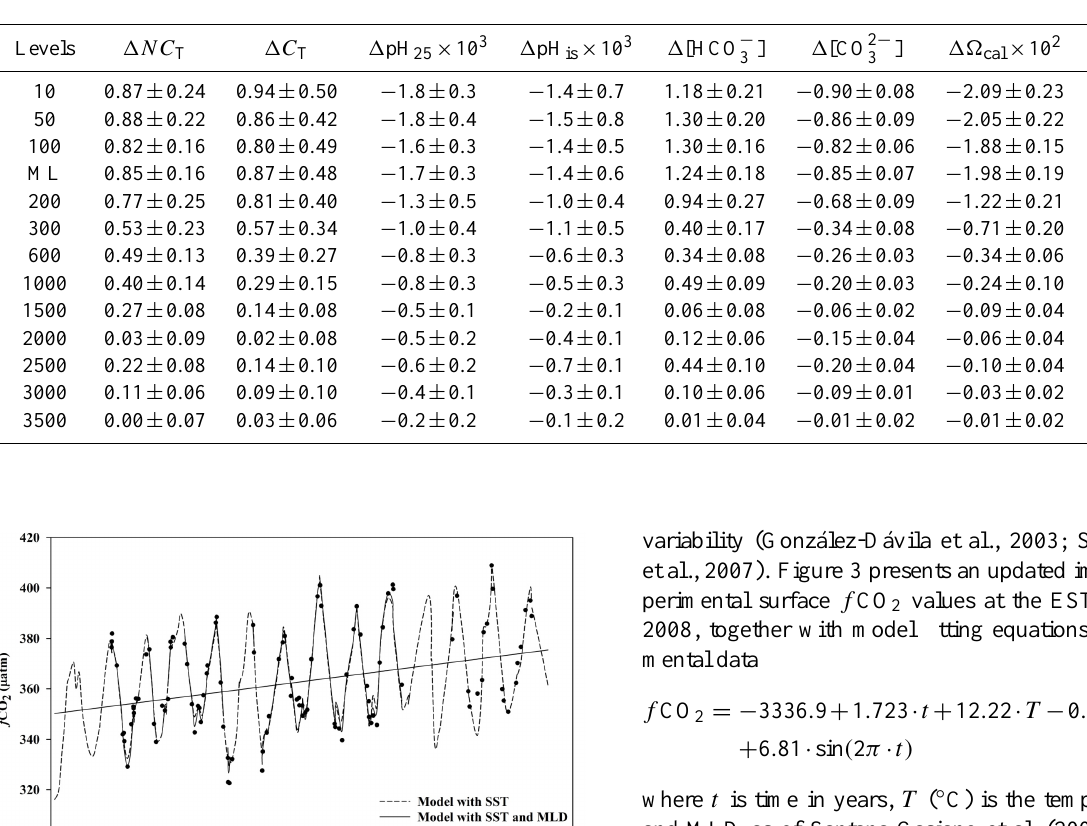
Table 1. The time series of properties at ESTOC over 12 selected depths and for the mixed layer (ML) for the decade 1995 to 2004. Linear regression coefficients and standard deviation at ESTOC provided the rate of change (expressed as 1X i in µmolkg − 1 yr − 1 ) for the carbonate system variables.